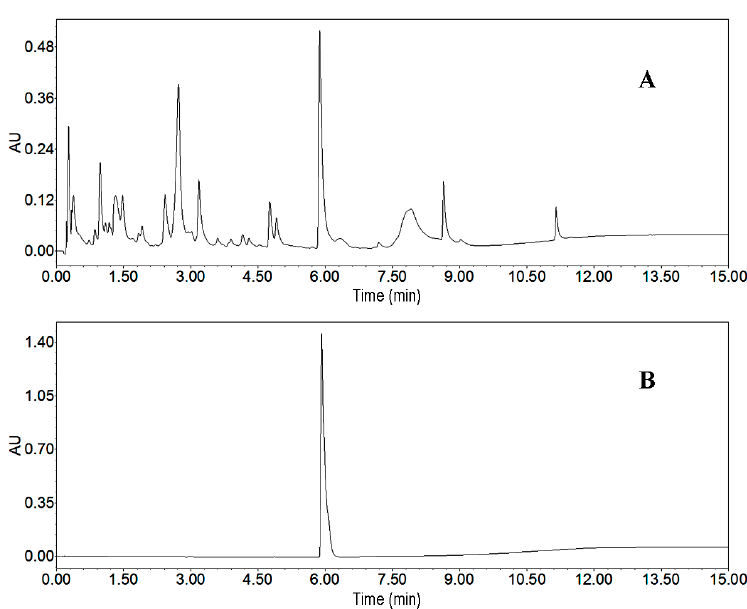
Figure 4. UPLC chromatograms. ( A ) crude sample from Streptomyces strain SYYLWHS-1-4; ( B ) HSCCC fraction of peak 2. Conditions: column, Waters ACQUITY UPLC Column (Milford, CT, USA), 100 mm × 2.1 mm, ID, 1.7 μ m; column temperature, 25 °C; mobile phase, methanol and water at the gradient (methanol: 0–10 min, 10%–90%; 10–15 min, 90%); flow rate, 0.5 mL/min; detection wavelength, 220 nm.